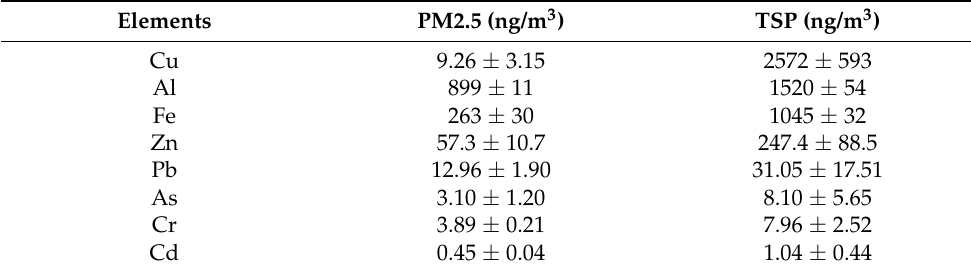
Data shown as mean ± S.D.